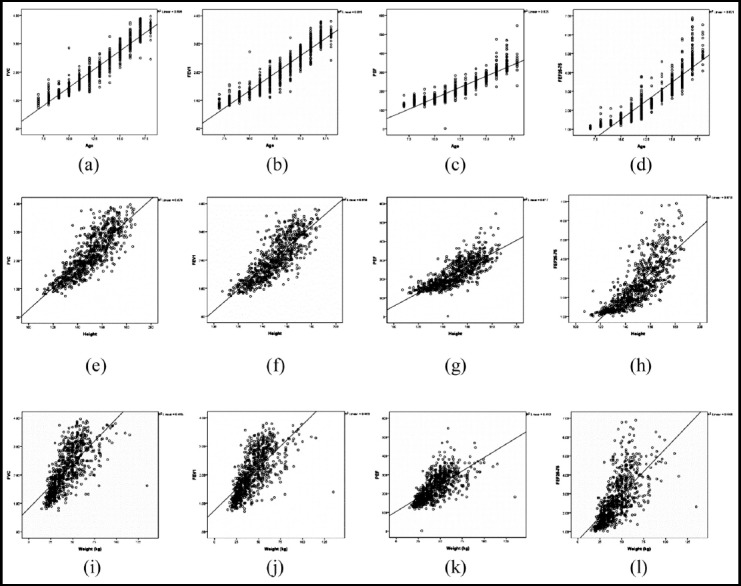
Correlation of (1)age with (a)FVC (b)FEV1 (c)PEF (d)FEF25-75 (2)height with (e)FVC (f)FEV1 (g)PEF (g)FEF25-75 (3)weight with (i)FVC (j)FEV1 (k)PEF (l)FEF25-75